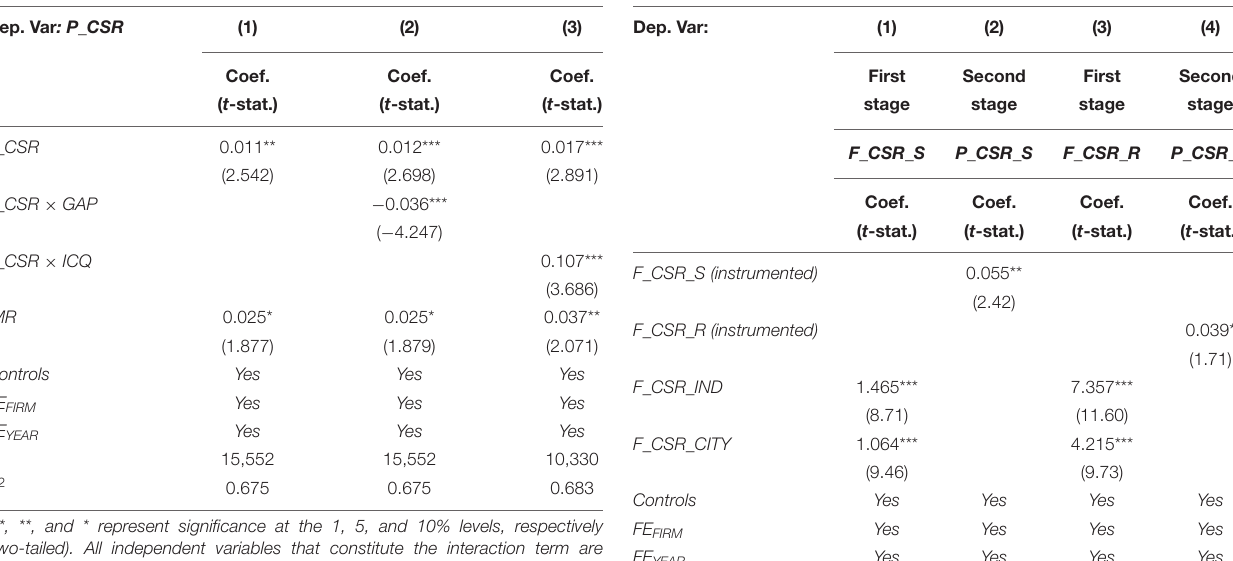
TABLE 9 | Heckman two-stage model (the second